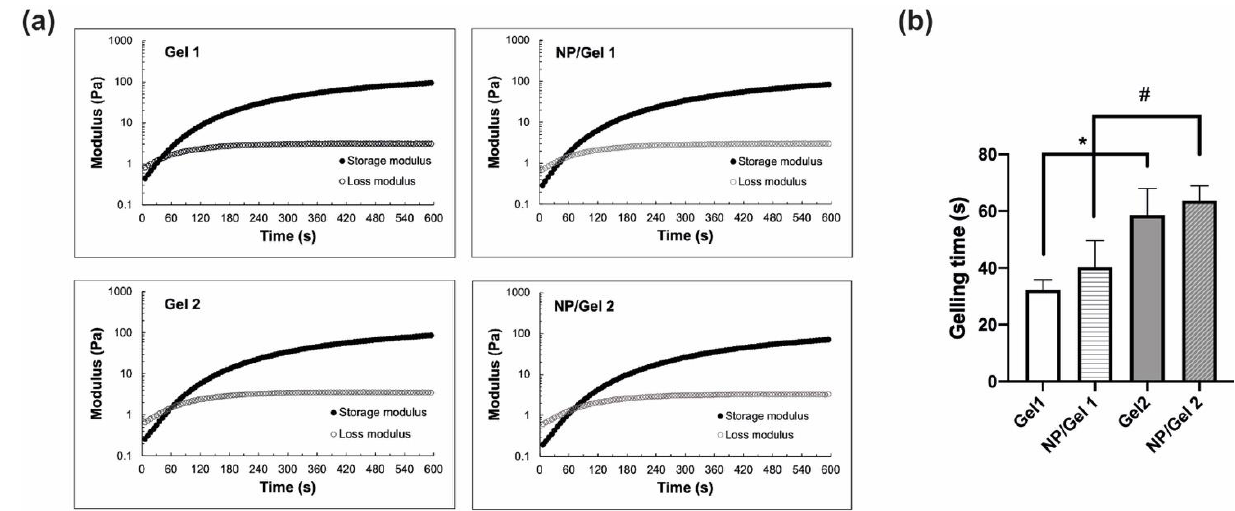
Figure 3. ( a ) Rheological properties of Gel 1, Gel 2 and nanoparticles (NP)/Gel composites obtained via time sweep with 1 Hz frequency and 5% strain at 37 °C ( n = 3). ( b ) Gelling time of the different Gel and its NP/Gel composite ( n = 3). Statistical analysis comparing between Gels or NP/Gel composites, *, # p < 0.05.